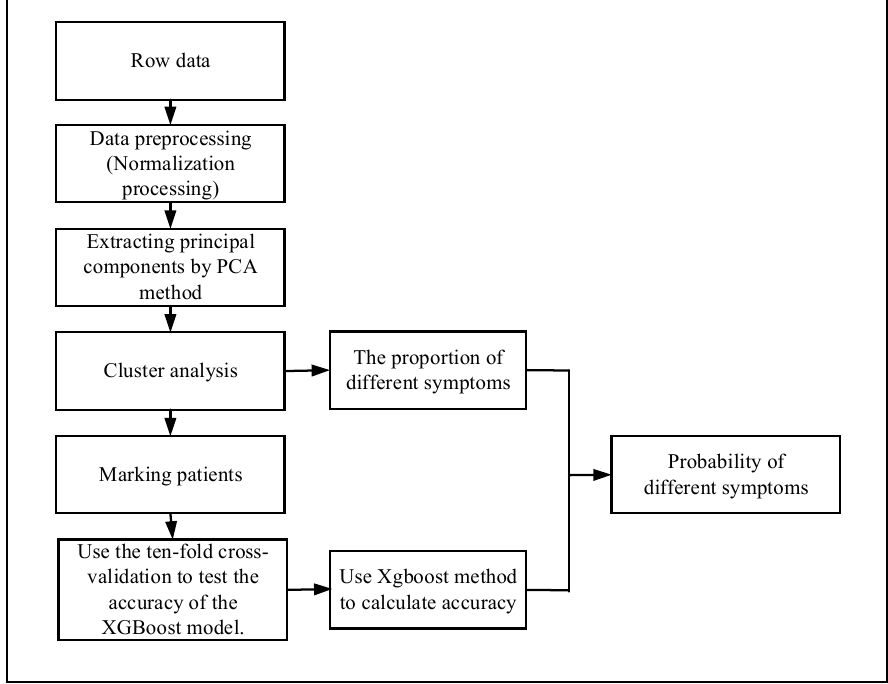
Figure 2. Probability analysis flow chart.